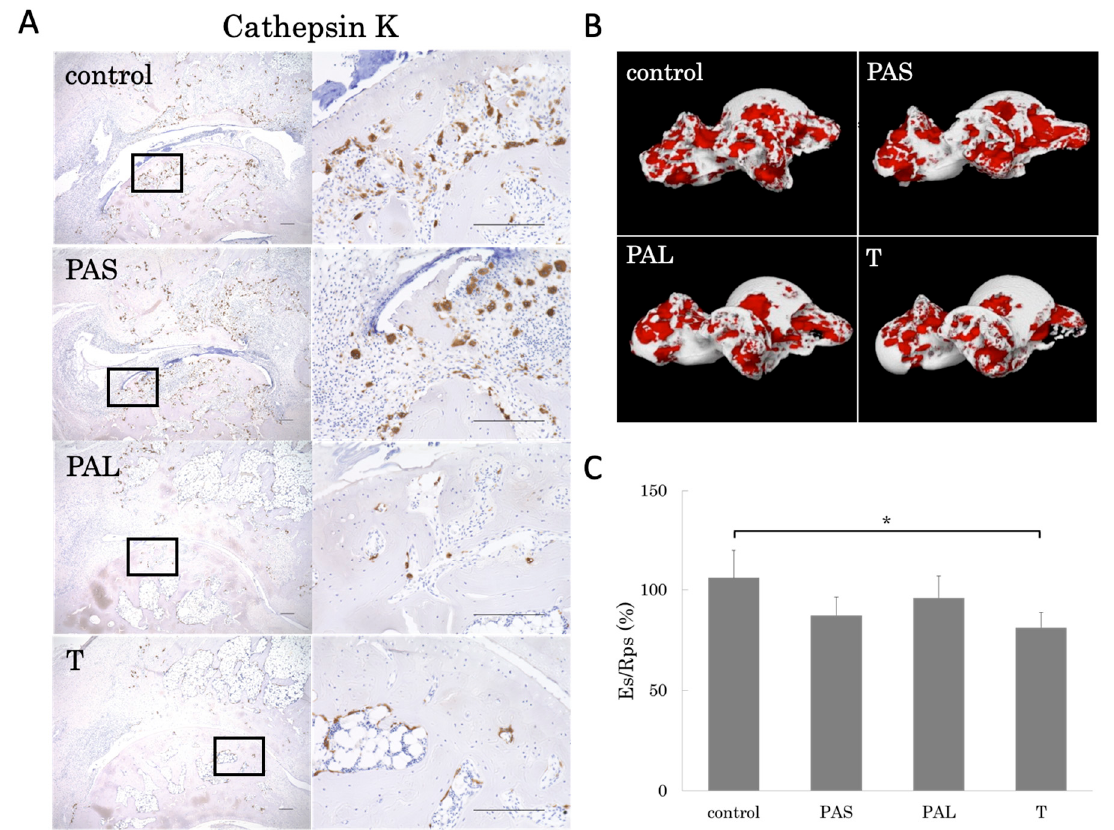
Figure 5. ( A ) Representative micrographs of cathepsin K immunohistochemical staining. Cathepsin K positive cells were fewer in the PAL and T groups. ( B ) Representative 3D reconstruction of bone erosion area in the whole talus architecture. Red area is bone erosion area. ( C ) The eroded bone surface (Es) and repaired bone surface (Rps) was calculated using 3D- µ -CT, and Es / Rps values are shown for the four groups. Es / Rps was significantly lower in the T group compared to the control group. * p < 0.05. Scale bar = 200 µ m. The black spot represents the position in the high-magnification figure.